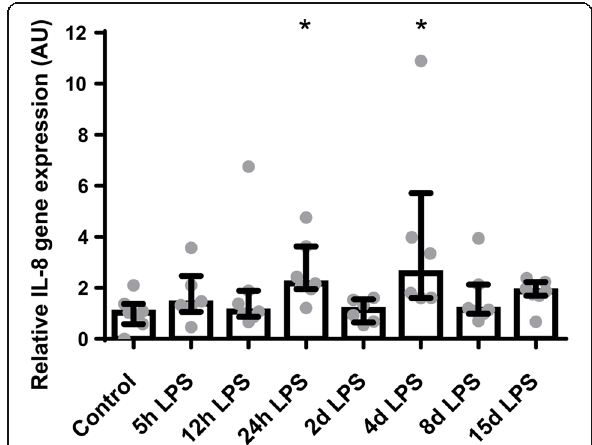
Fig. 3 Relative gene expression of IL-8 in arbitrary unit (AU).